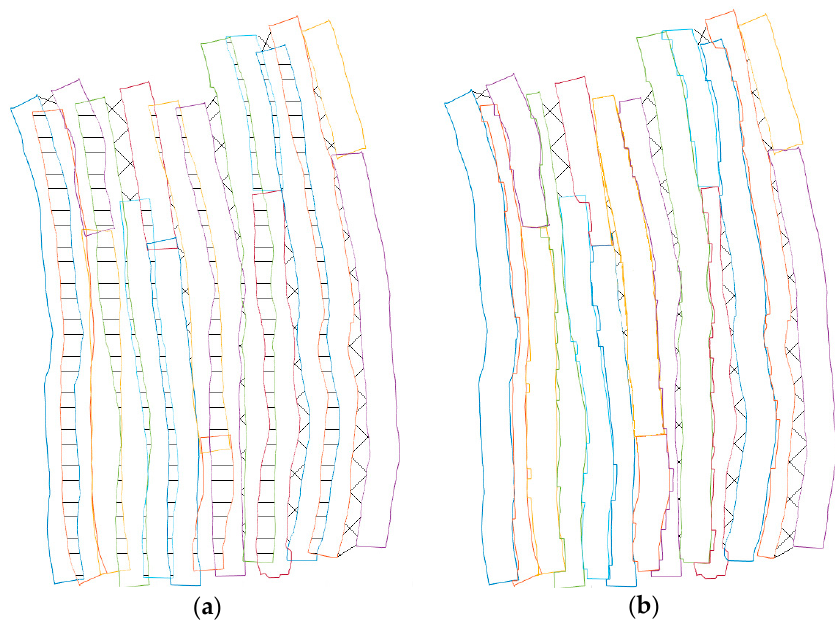
Figure 7. Distribution of data points is determined by track navigation. ( a ) Horizontal hatching indicates overlapping areas and thus these areas contain denser data. Diagonal hatching indicates data gaps, which can be avoided by good navigation skills in most cases. ( b ) The alpha-shape approach can remove most of the data overlaps and even data distribution can be achieved for further processing.